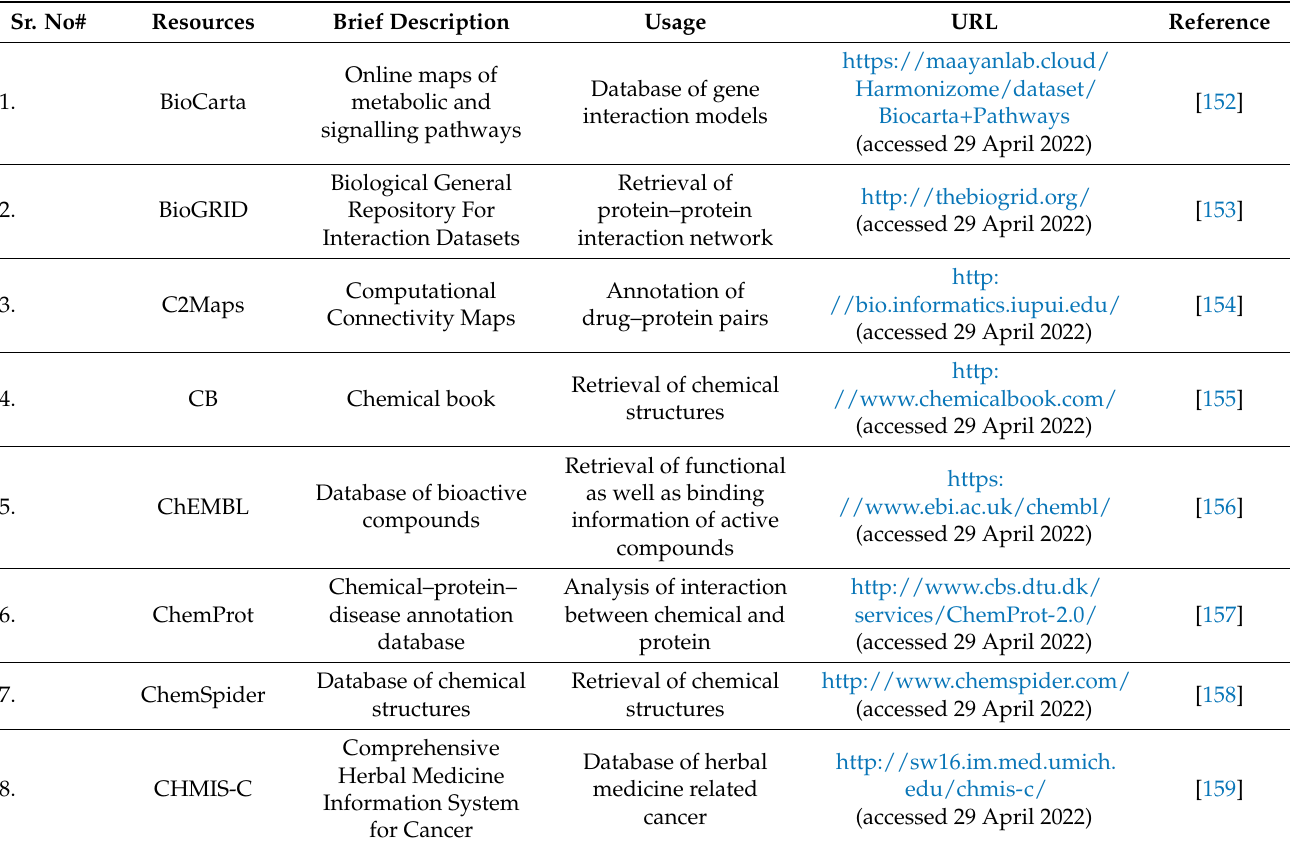
Table 1. List of available resources for network pharmacology